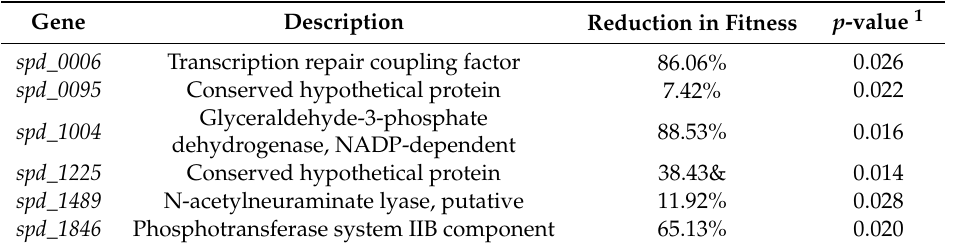
Table 2. S. pneumoniae D39 genes essential for growth in rabbit vitreous